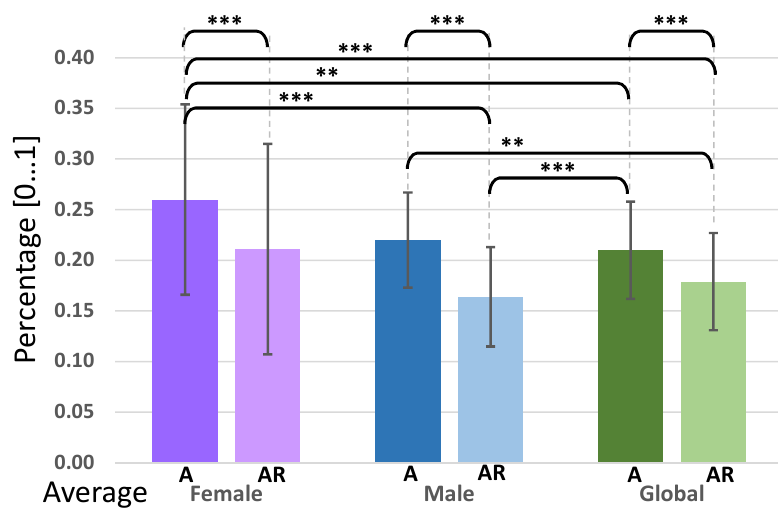
Figure 4. Agreement scores (A) and co-agreement rates (AR) by gender.